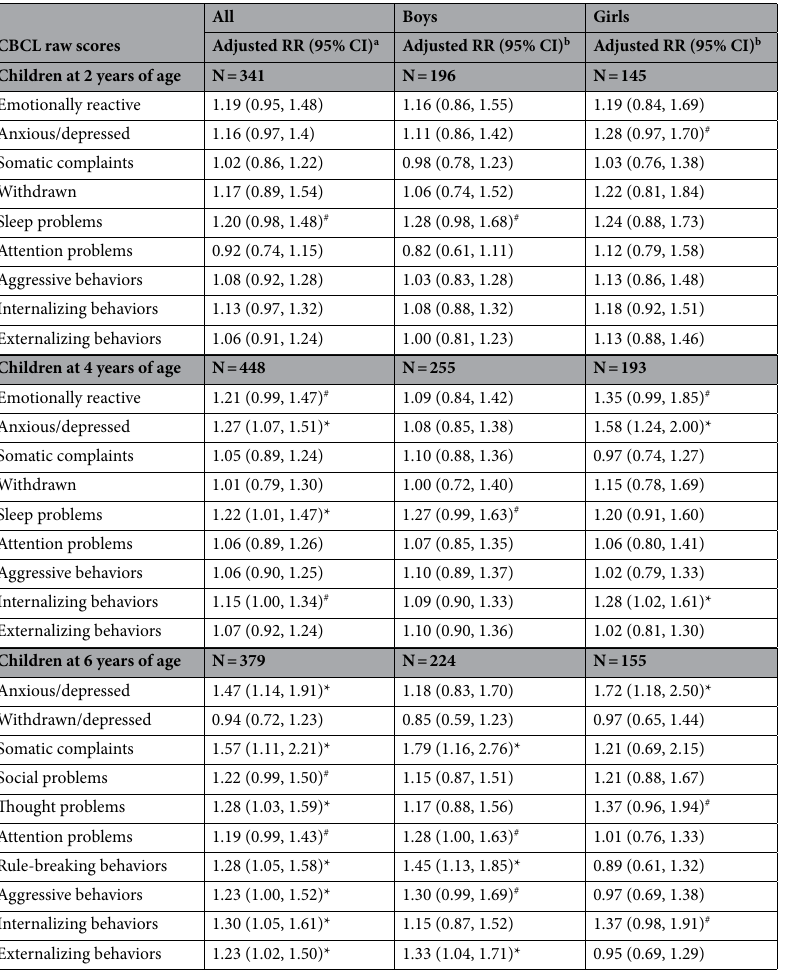
Table 4. Associations between preconceptional paternal alcohol consumption and CBCL raw scores at 2, 4 and 6 years of age in children without paternal smoking. CBCL Child Behavior Checklist. *Statistically significant differences ( P -value < 0.05). # P -value < 0.10. a Adjusted for paternal age, paternal body mass index, paternal education, maternal age, parity, maternal depressive symptoms during pregnancy, maternal preconception folic acid supplements, multivitamin supplements during pregnancy, gestational weeks, and sex. b Adjusted for all potential confounding variables above except